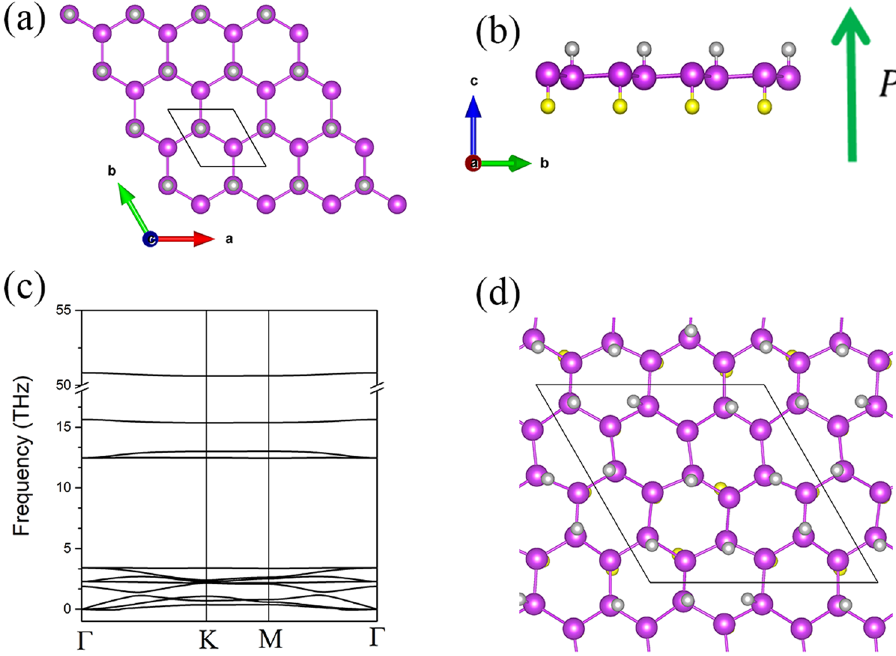
Figure 1. The atomistic structure of Bi 2 HF nanosheet ( a ) top view and ( b ) side view. The purple, gray and yellow balls denote Bi, H and F atoms, respectively. The big green arrow shows the direction of the intrinsic dipole polarization. ( c ) The phonon dispersion of Bi 2 HF nanosheet. ( d ) The snapshot from AIMD simulation of Bi 2 HF nanosheet at 300 K after 6